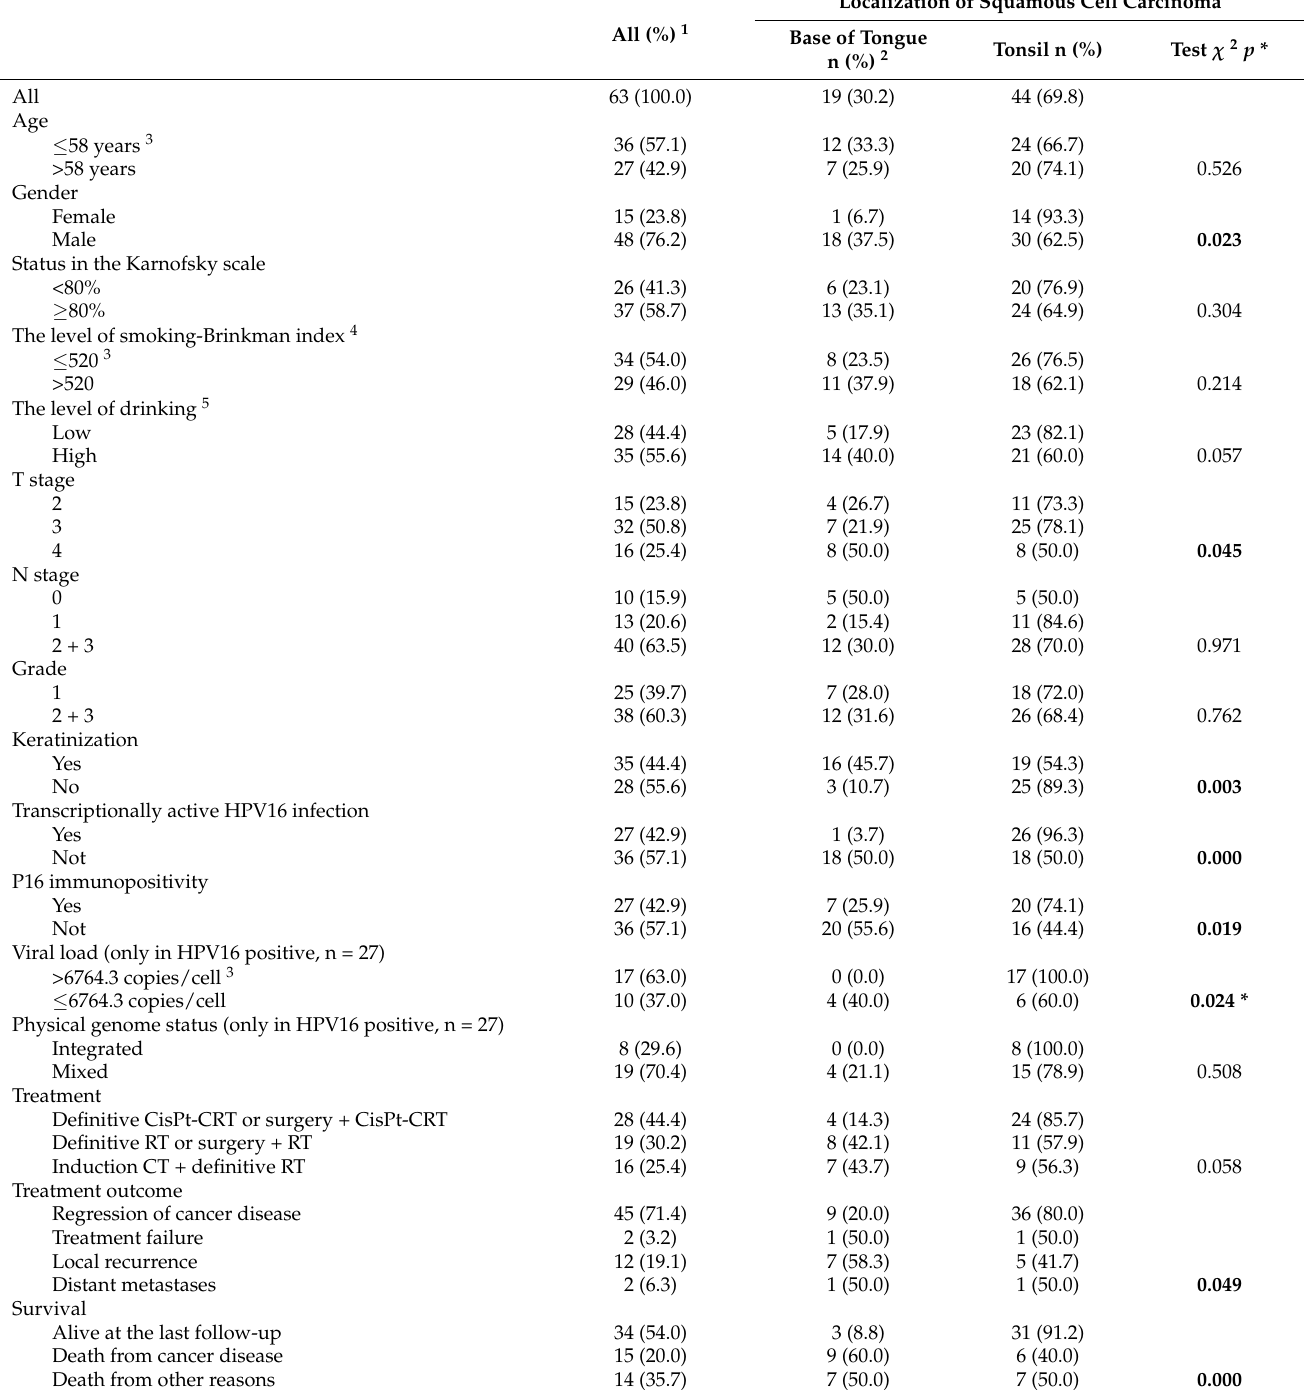
Table 1. Epidemiological, clinical, and histopathological features in the subgroups of patients with squamous cell carcinoma of base of tongue and